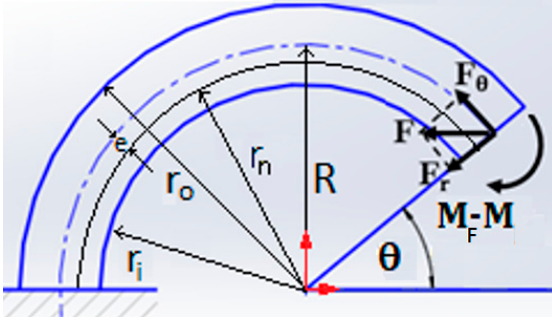
Figure 4. ( a ) Assembled sensor. ( b ) Boundary conditions.